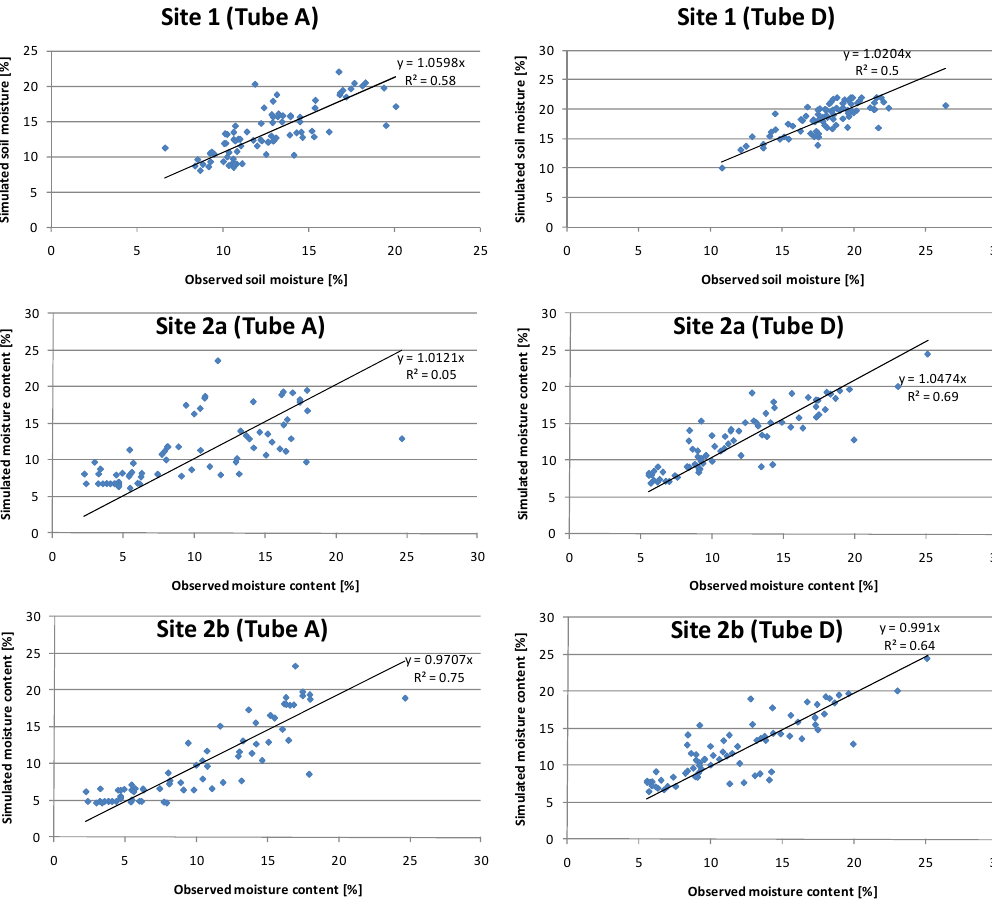
Figure 5 Comparison of observed and modelled moisture in Tube A (control) and Tube D .